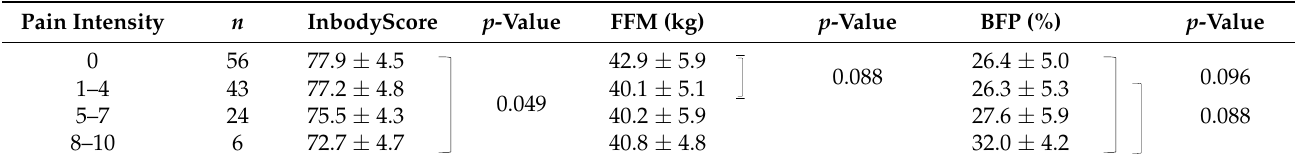
FFM: fat-free mass; BFP: body fat percentage.